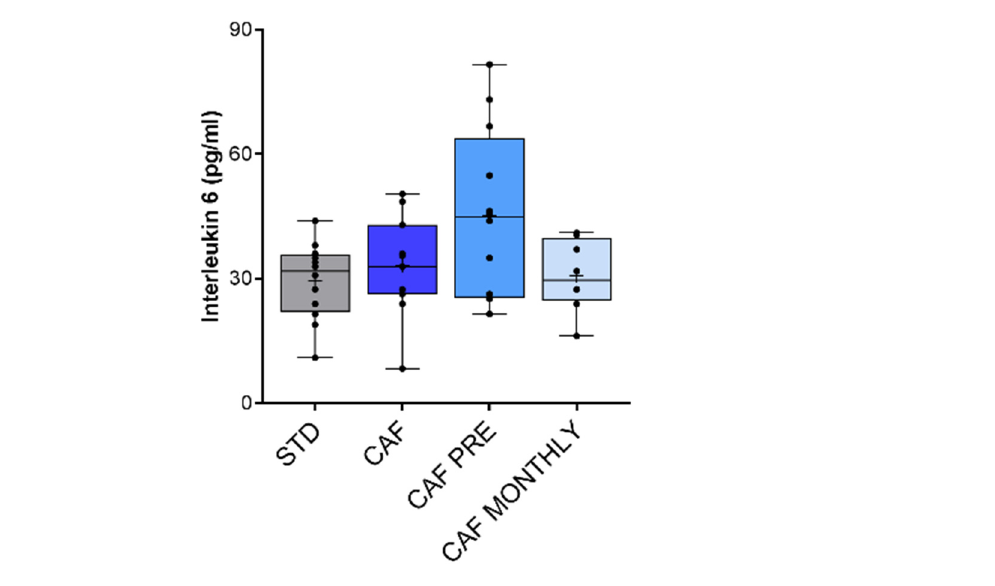
Figure 7. Interleukin-6 levels as biomarker of systemic inflammation. STD: lean rats fed a standard diet; CAF: rats fed a cafeteria diet; CAF PRE: rats receiving preventive treatment of GSPE during 10 days before cafeteria diet intervention; CAF MONTHLY: rats receiving GSPE treatment during 5 days once per month simultaneously fed with cafeteria diet. Values are represented as boxplots showing the median and the IQR. Means are represented as +.